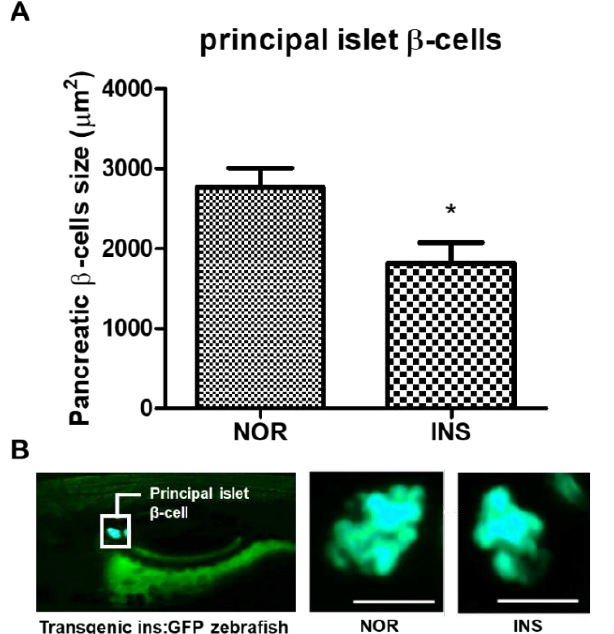
Figure 3. Changes in pancreatic β -cells following insulin (INS) treatment. ( A ) Principal islet β - cells ’ size of the excess insulin-treated zebrafish ( n = 20). (*) p < 0.05; compared to normal (NOR). ( B ) Fluorescent microscopic image of the principal islet β -cells. Scale bar = 100 μm.